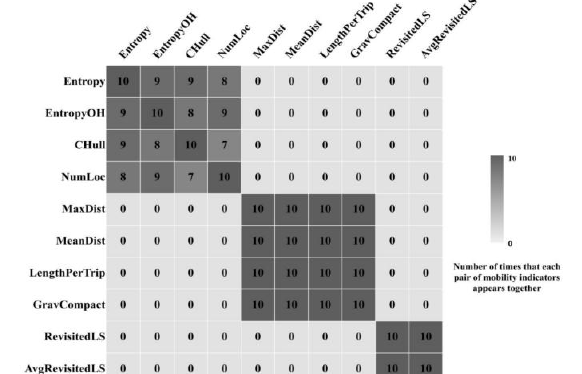
Figure 2. EFA summary matrix for the 10 runs of the random day selection. The counts indicate how often each pair of mobility indicators co-appears in a